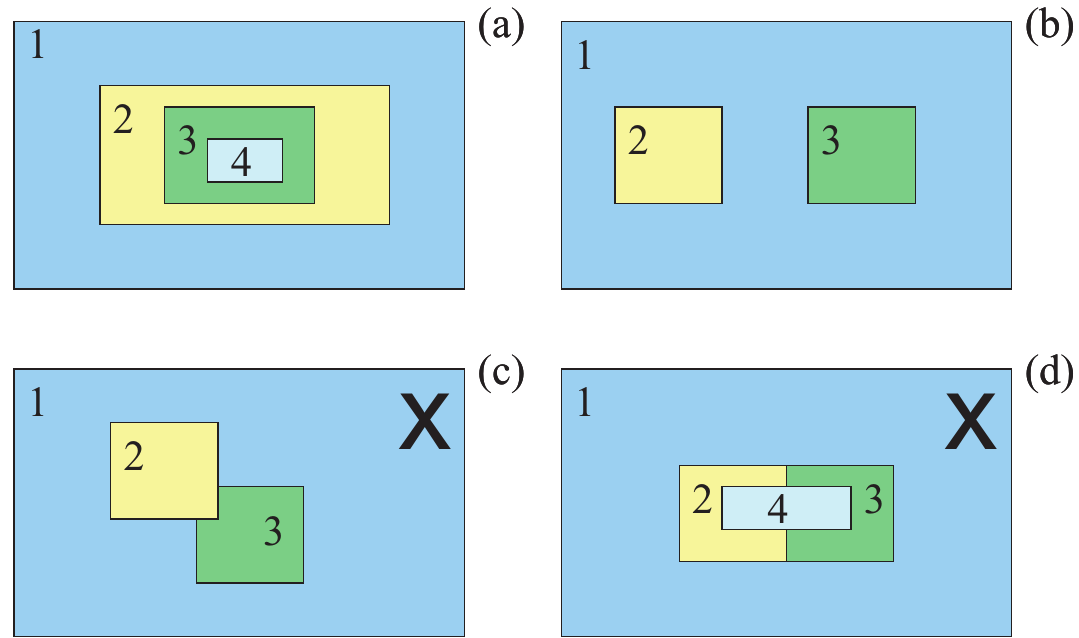
Figure 7.2: Various nest configurations for multiple grids. (a) Telescoping nests. (b) Nests at the same level with respect to a parent grid. (c) Overlapping grids: not allowed (d) Inner-most grid has more than one parent grid: not